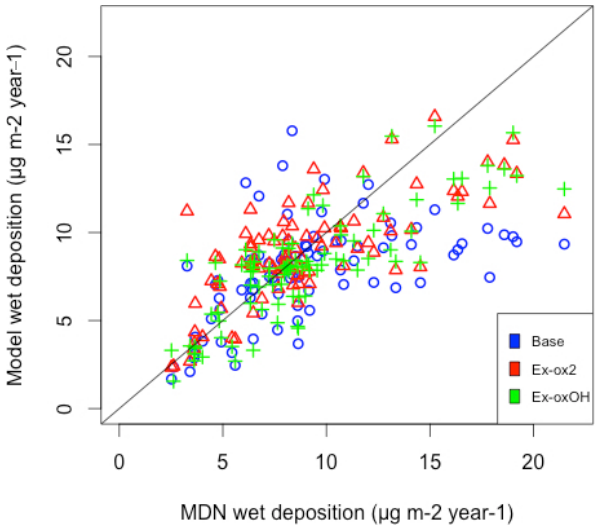
Fig. 7. Yearly averages (2005) of modelled wet deposition concen- tration plotted against MDN wet deposition measurements.